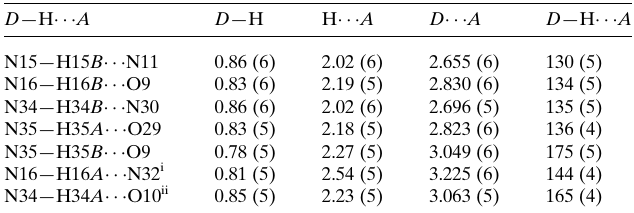
Table 1 Hydrogen-bond geometry (A˚ , (cid:3) ).